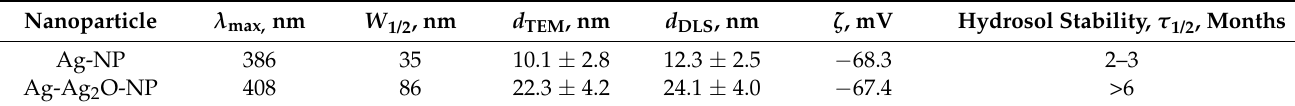
Table 1. Characteristics of silver nanoparticles.